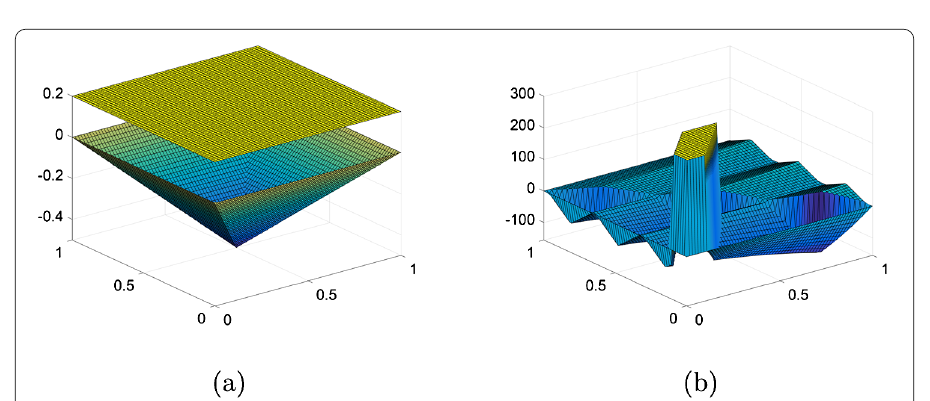
Figure 5 Numerical solutions u h and errors u h – u ∗ at the 64 × 64 resolution. (a) - (b) by the PDL1P and (c) - (d) by the obstacle